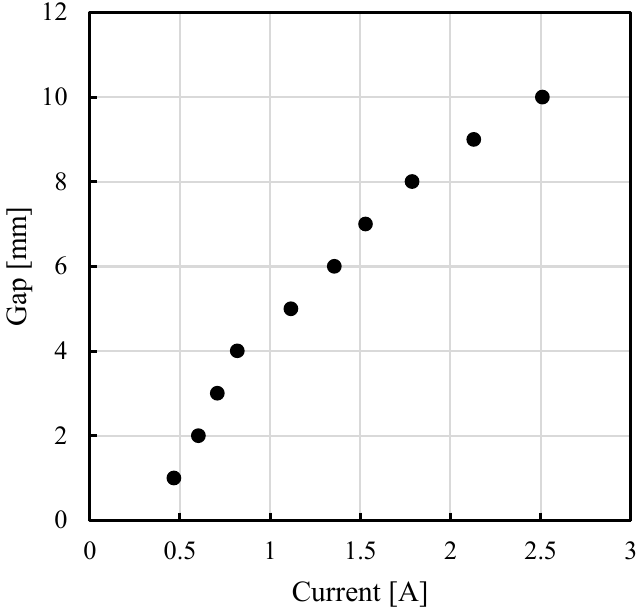
Figure 5. Relationship between the current of an electromagnet and the force of the steel plate in each gap. The dashed line shows the weight of the steel plate. The dots ( ･ ) show intersection points between the solid and dashed lines, and show possible conditions for levitation of the steel plate.